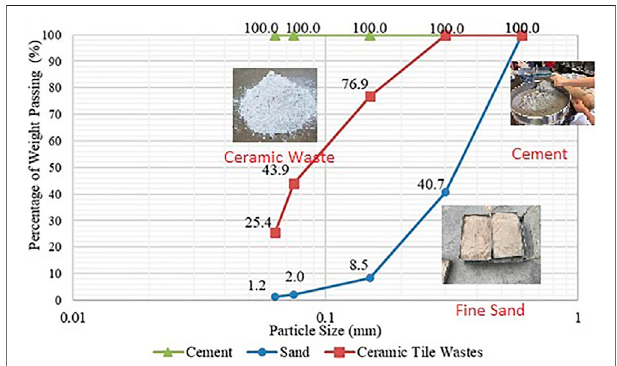
FIGURE 2 | Semi-log graph of percentage of weight passing against particle size for cement, sand, and ceramic tile wastes.